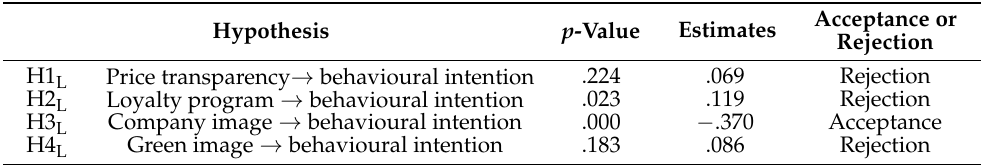
Figure 3. Summary of the research results (L group). Note: ** p < .001; * p < .05 ns—nonsignificant. Table 5. Verification of research hypotheses (L group).